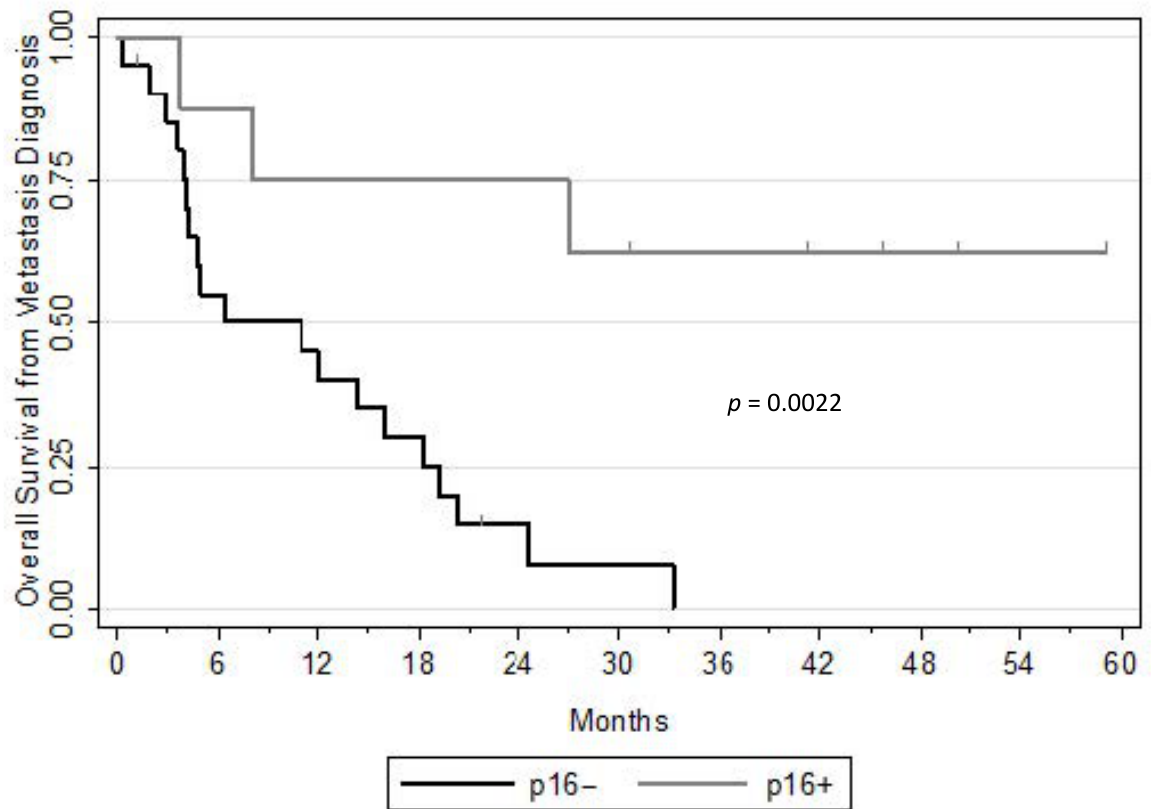
Figure 1. Overall survival after distant failure according to p16 status n =